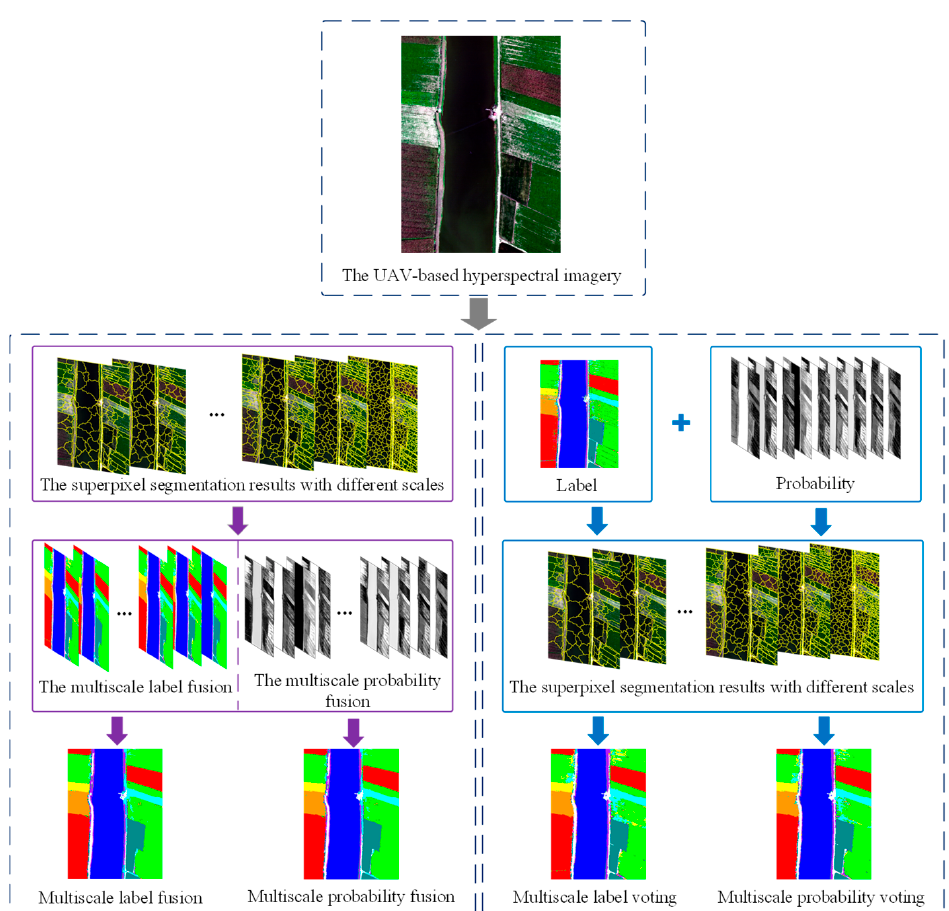
Figure 1. Flow chart of the research.